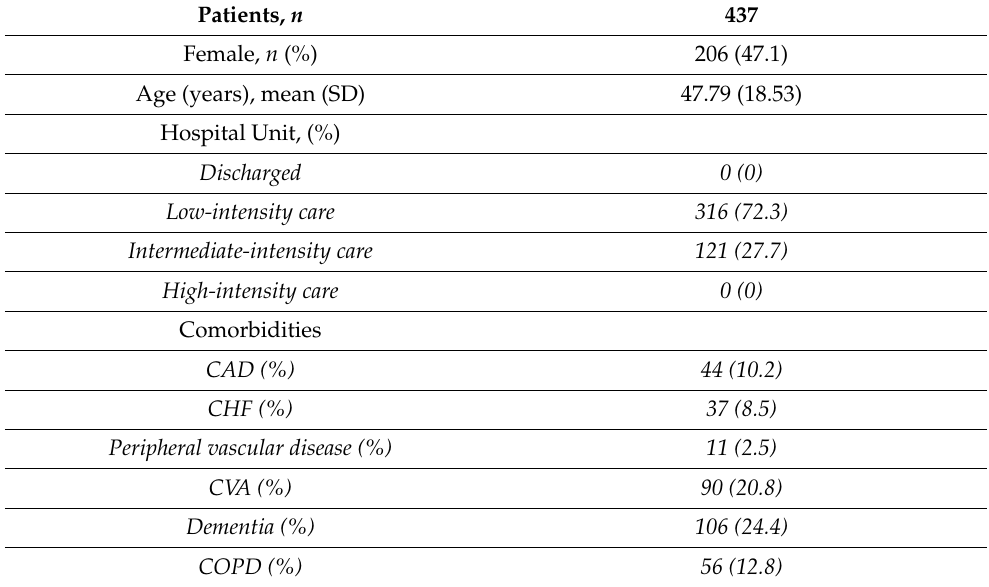
Table 2. Features of the sample at